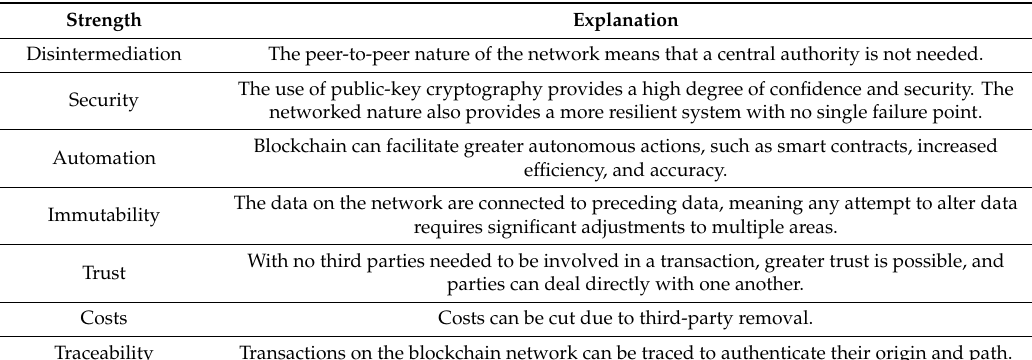
Table 1. Blockchain major characteristics [16] (p. 2).